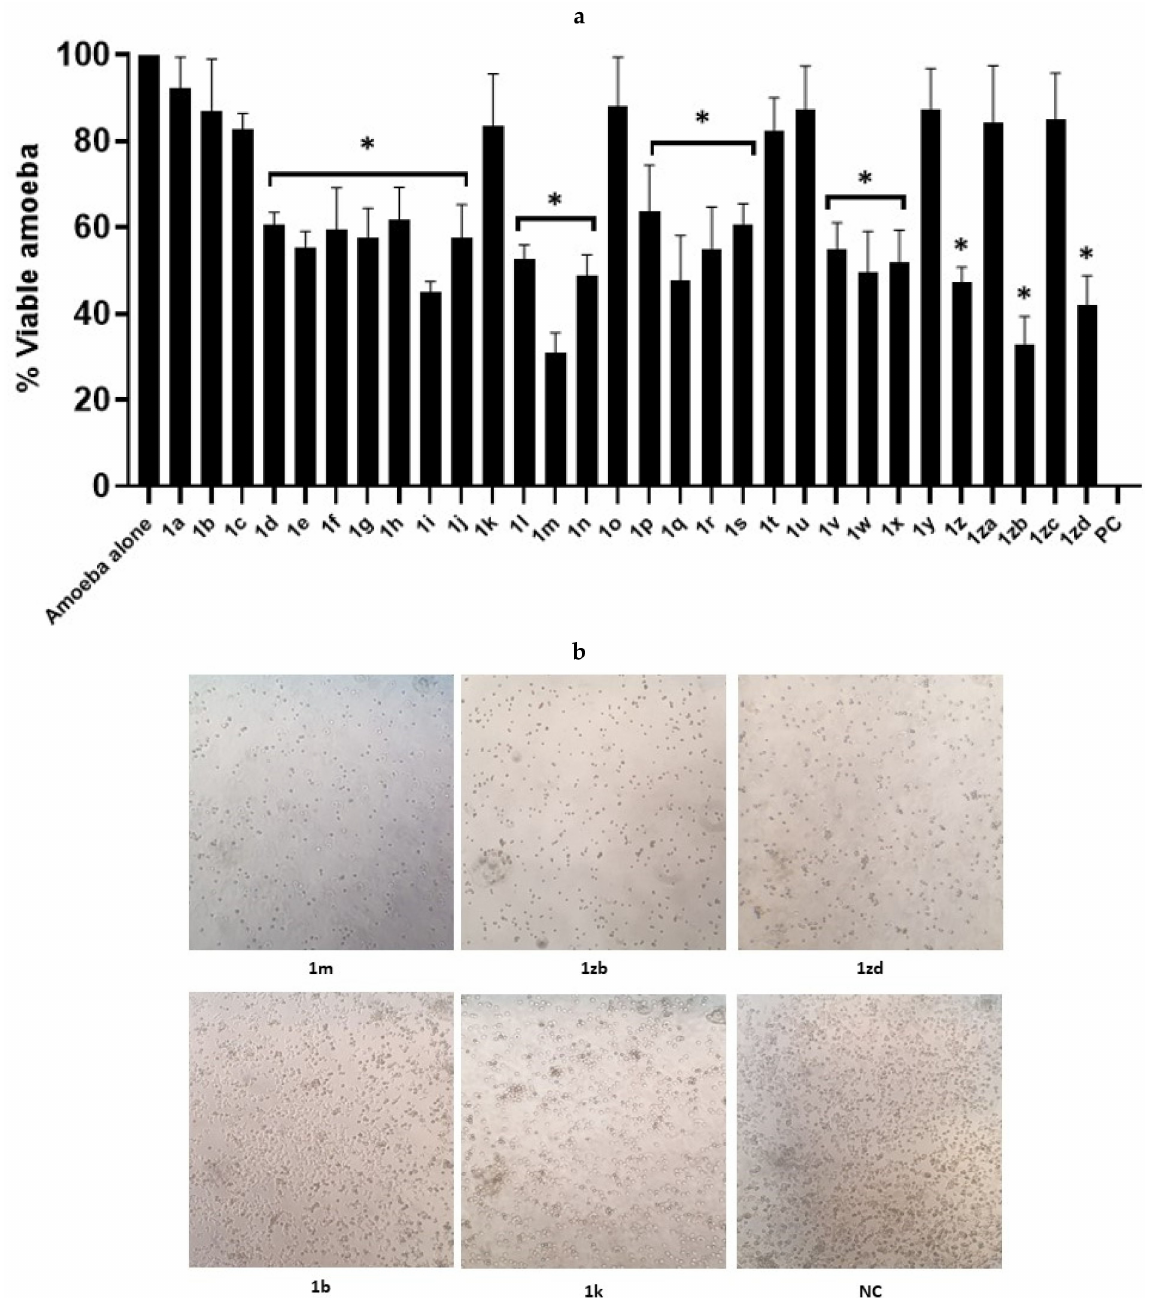
Figure 1. Compounds with notable amoebicidal activities against A. castellanii . Briefly, compounds were incubated at 50 µ M concentration with A. castellanii (5 × 10 5 ) at 30 ◦ C for 24 h. Next, viable amoe- bae were enumerated by haemocytometer using inverted microscope. Amoebae cultured in RPMI alone was considered as negative control and with 0.25% SDS as positive control. ( a ) Amoebicidal effects of compounds and their analogues against A. castellanii . ( b ) Illustrative effects of compounds and their analogues on the amoeba viability. The NC represent the negative control (amoebae alone) while PC indicate the positive control. Images are shown at 100 × . The data is expressed as the mean ± standard error. p values were determined using two sample t -test, two-tailed distribution, (*) is p ≤